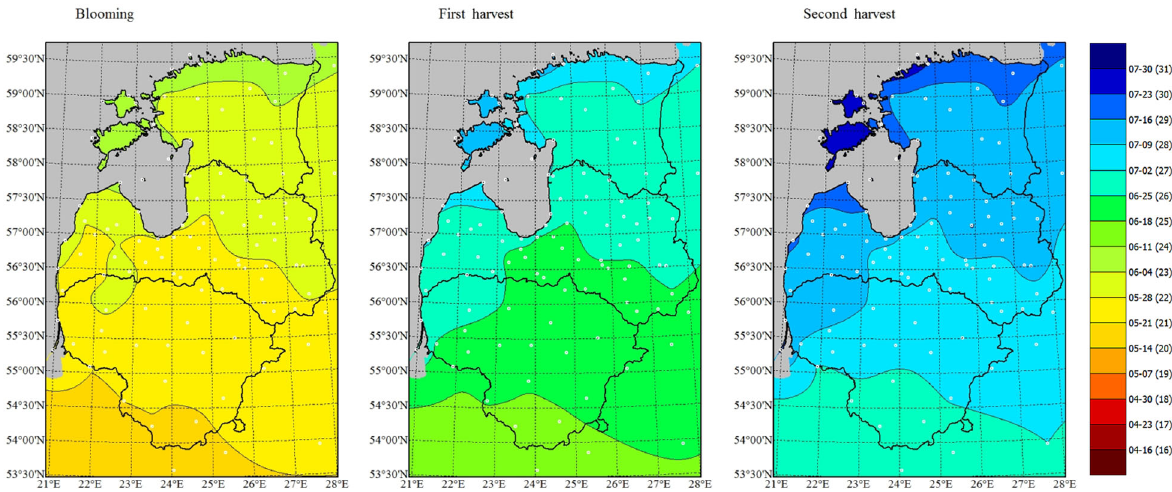
Fig. 5. Timing of strawberry development, weeks of the year, present climate (2001–2030). White dots show the locations of stations used for RCM data bias